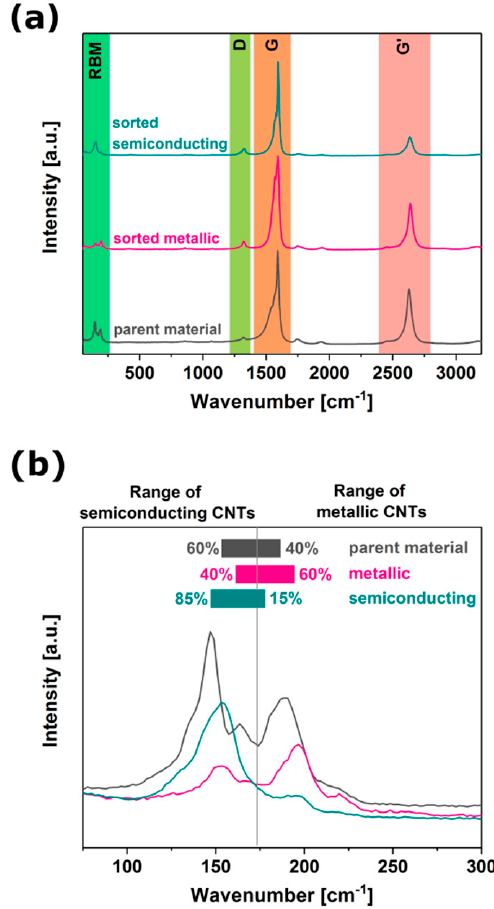
Figure 8. Raman spectra: ( a ) Overview of all the peaks, ( b ) magnification of RBM area.